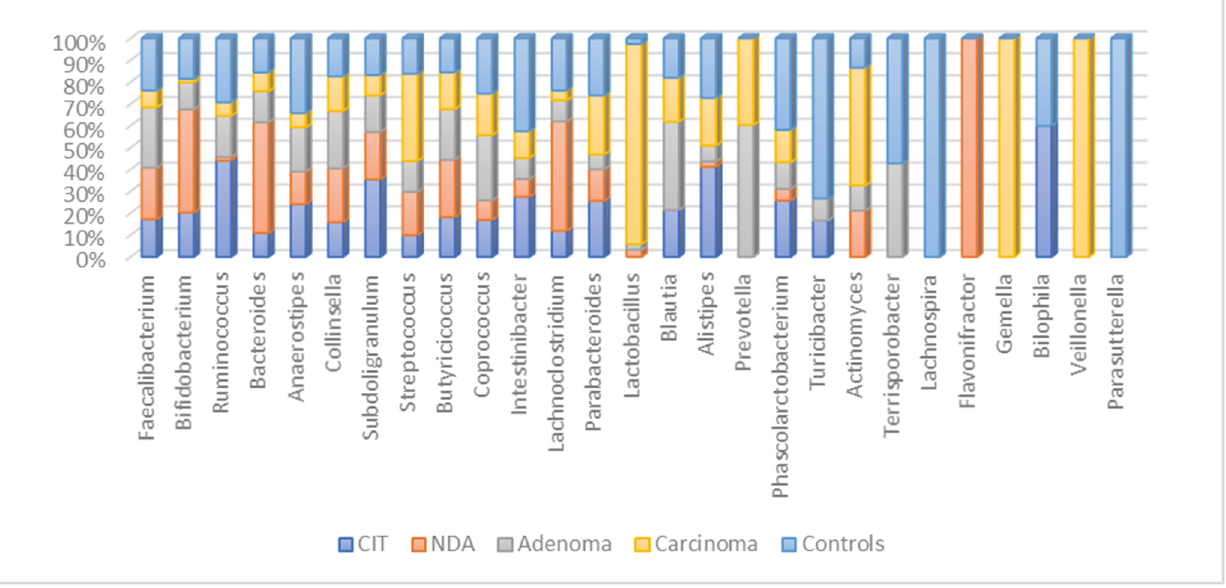
Figure 8. Genera abundance frequency patterns segregated by diagnostic and control groups. Table 6. Bacterial abundance tendency in the non-resistant samples